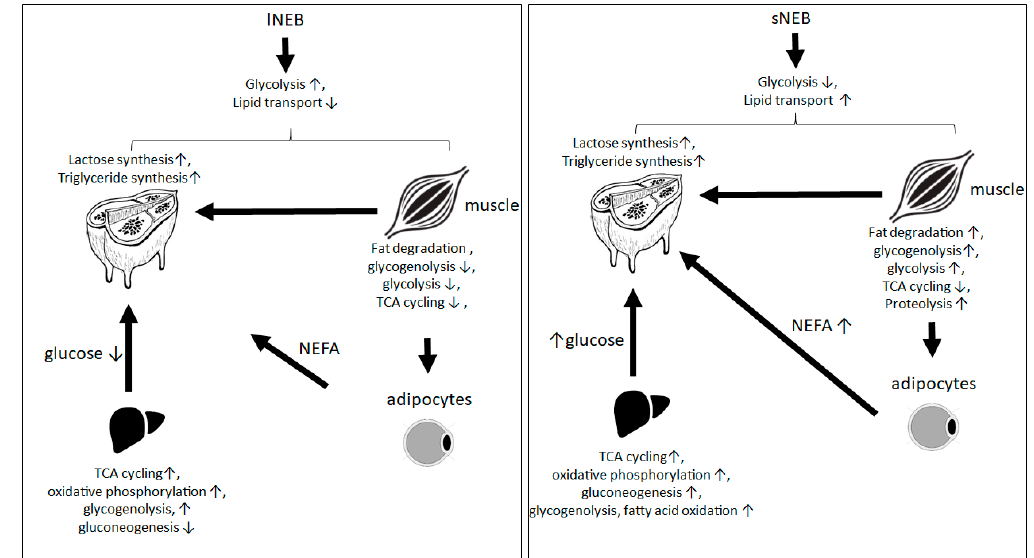
Figure 9. Resuming scheme of different NEB levels in the physiology of lactating cows. The represented arrows represent the trend of the de-regulated metabolisms, pathways, and metabolites in sNEB cows in comparison to lNEB cows. Up arrow ( ↑) and down arrow ( ↓) refer to increased and decreased concentrations/activity, respectively.